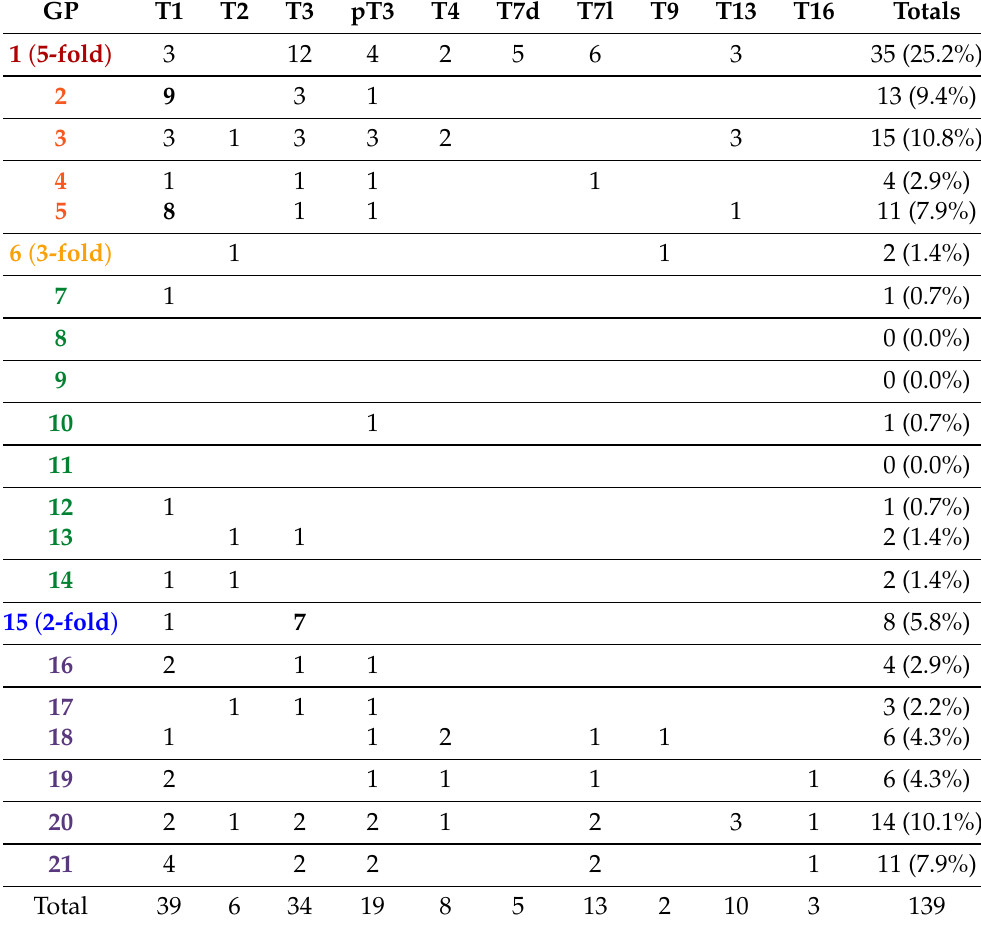
Table 3. Gauge Points of Protruding Features vs. T-number. In total, we found 149 structurally significant protruding features within the AU when analyzing the 135 icosahedral capsids data set found in VIPERdb [1]. We found that most viruses have only one significant structural protrusion ( 90% ) and the rest had two significant structural protrusions ( 10% ) ; no virus has more than two. In general, knowing the location of a structural protrusion does not strongly indicate the T-number. However, there are some exceptions—GP 2 is mainly used by T1 capsids ( 69% ) , GP 5 is mostly used by T1 capsids ( 73% ) and the 2-fold axes (GP 2) is primarily T3 ( 88% ) . We also found that few viral protrusions ( 6.5% ) were found in the region from the 3-fold axes (GP 6) to the 2-fold axes (G15), though the 2-fold (GP 15) is well populated. There are 10 viruses with T-numbers larger than T16 not shown here, and they all had a single structurally significant protrusion located at the 5-fold axes (GP 1) or along the 5–2 region at GP 21. Capsids with two structural protrusions ranged from from T1 to T13 and included each of the four genome types. Numbers appearing in bold are the large majority T-number at these gauge points. This data can be visualized in Figure